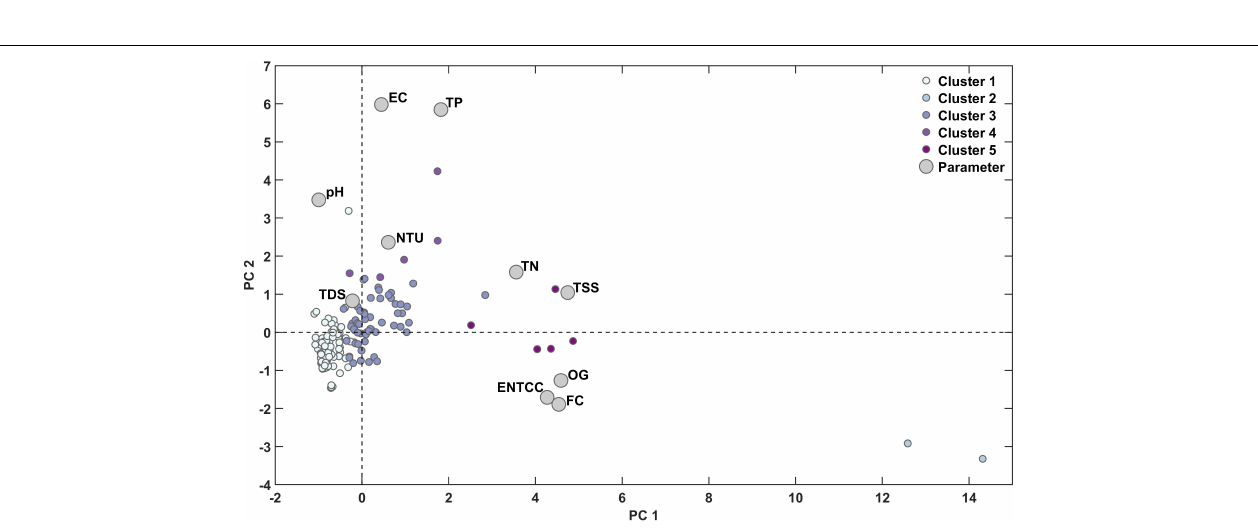
FIGURE 4 | PCA scores in five clusters. PC1 explains 65% and PC2 21% of the variance. Coefficients or parameters illustrate how each pollutant variable contribute to the two principal components.